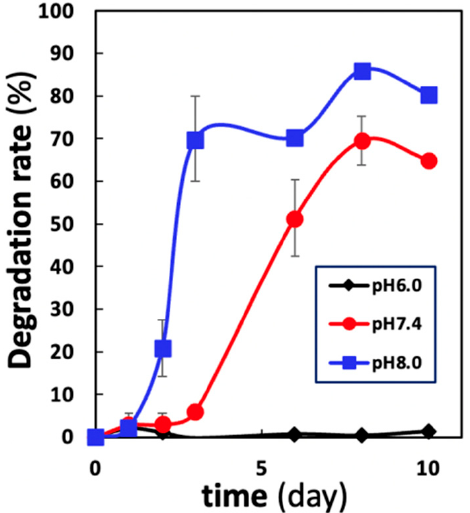
Figure 1. Time–course changes in the degradation rate of CHPA nanogels in different pH buffers. The degradation rate of CHPA nanogels in different pH buffers (pH 8.0, 7.4, and 6.0). Nanogels were immersed in three buffer solutions of pH 6.0, 7.4, and 8.0 at a volume ratio 100 times greater than that of the nanogel, and samples were collected over time up to day 10. The degradation rate was calculated as the percentage of the amount of nanogel released after immersion in the buffer solution divided by the amount of nanogel that was initially immersed.